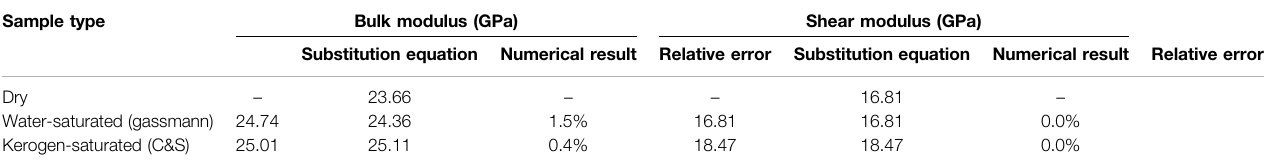
TABLE 1 | The simulation and substitution equation results of the test sample. Sample type